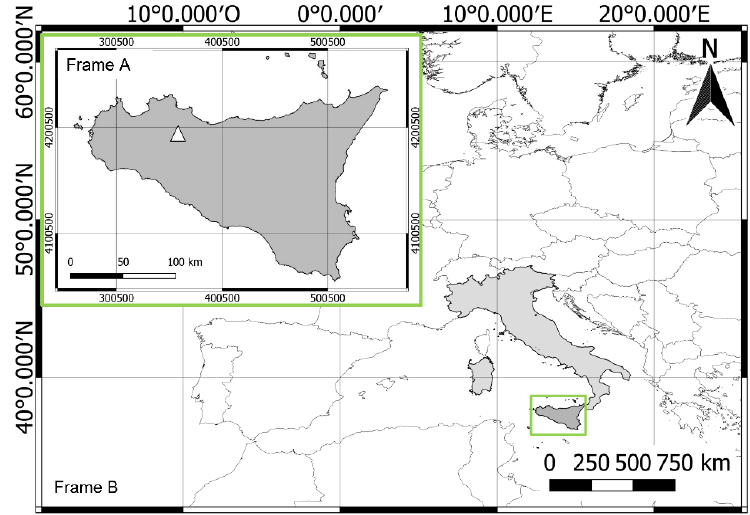
Figure 1. The location of the old-growth forest (white triangle) in the “Bosco della Ficuzza, Rocca Busambra, Bosco del Cappelliere, Gorgo del Drago” Regional Nature Reserve in Sicily (dark grey, Frame A, Projected CRS ETRF2000-RDN2008 UTM zone 33N-EPSG: 6708). The location of Sicily within the Italian territory (light grey, Frame B, Geocentric CRS RDN2008-EPSG: 6706).